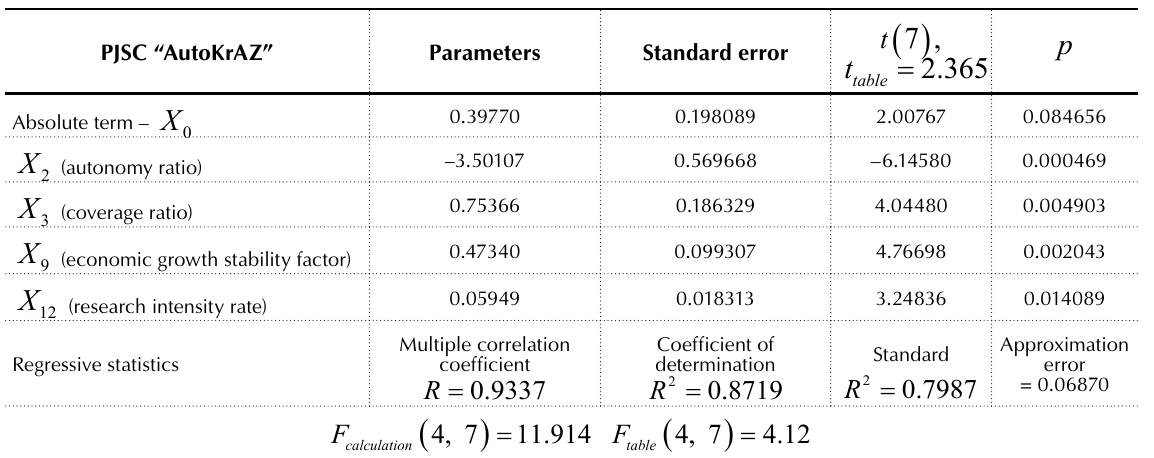
Table 4. Correlation and regression model of the internal capacity of technology transfer system development at PJSC